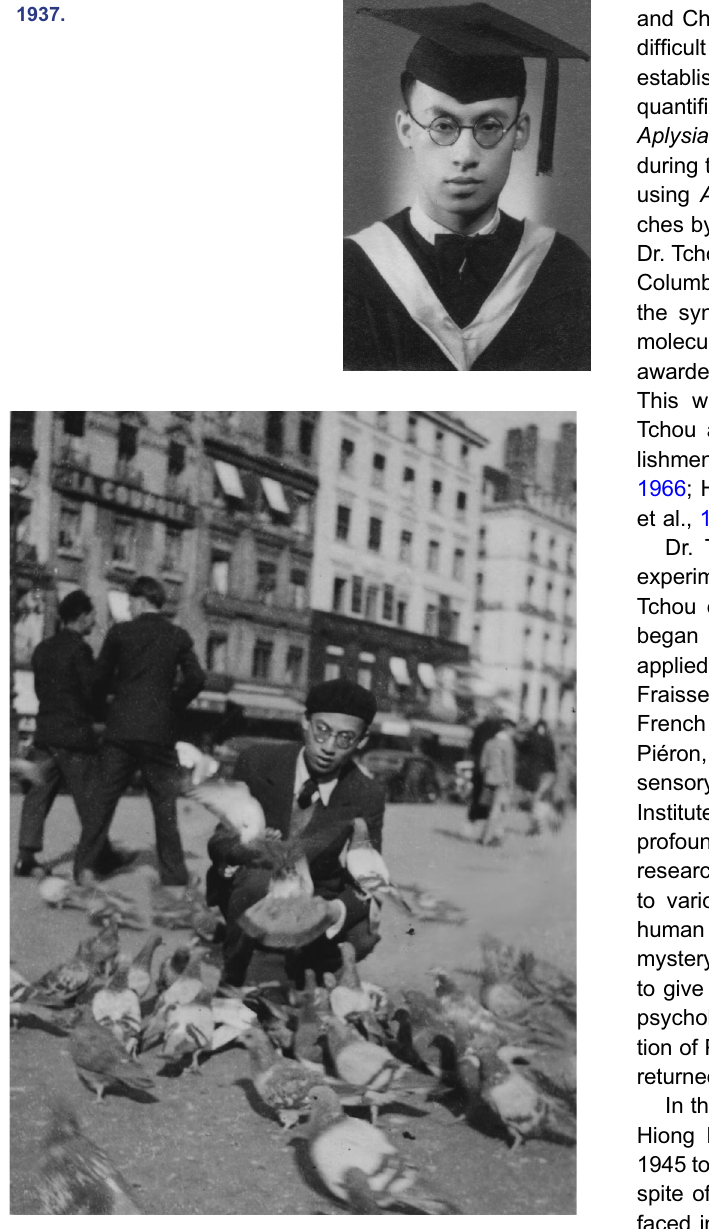
Figure 2. Si-Ho Tchou in